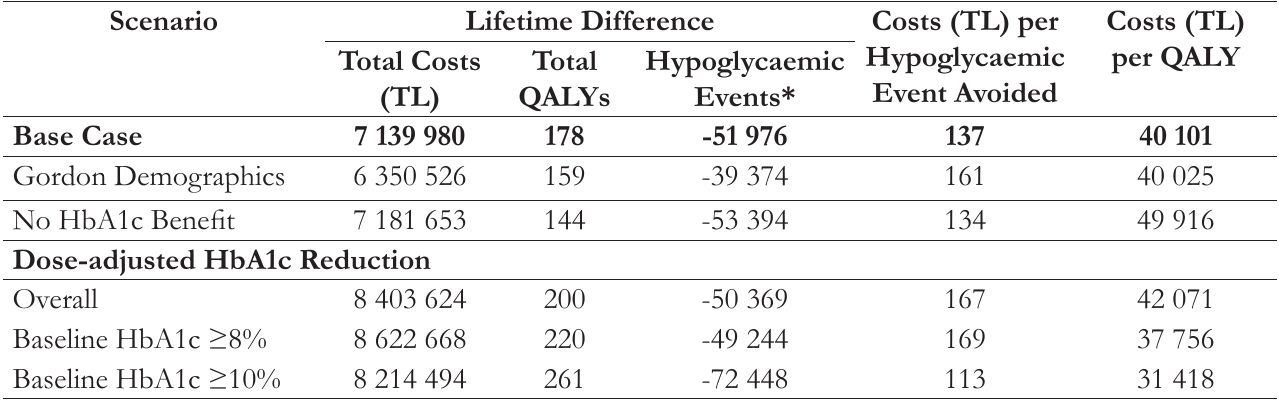
Table 6. Lifetime Results for a Cohort of 1,000 Patients Comparing Insulin Glargine to NPH Insulin